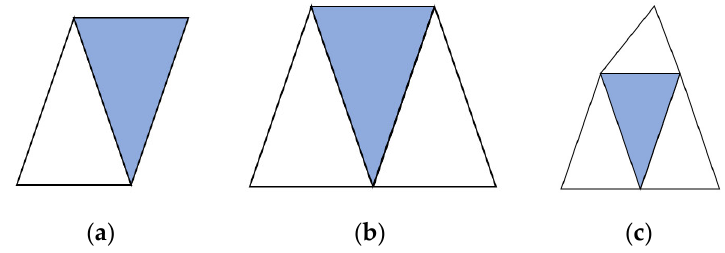
Figure 4. Triangle-type division. ( a ) Type I; ( b ) Type II; ( c ) Type III.